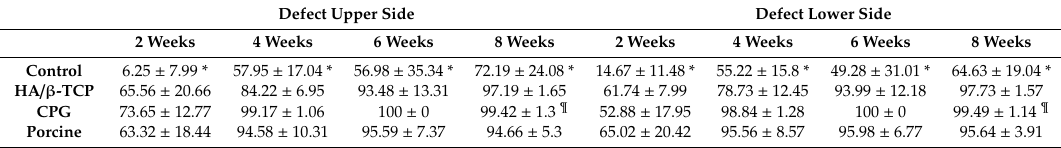
Figure 6. Upper view of critical size defects with non-closure in control defects vs. nearly complete closure with CPG, porcine graft, and HA / β -TCP over eight weeks. Table 2. Percentage of calvaria defect closure. CPG—collagenated porcine graft. Defect Upper